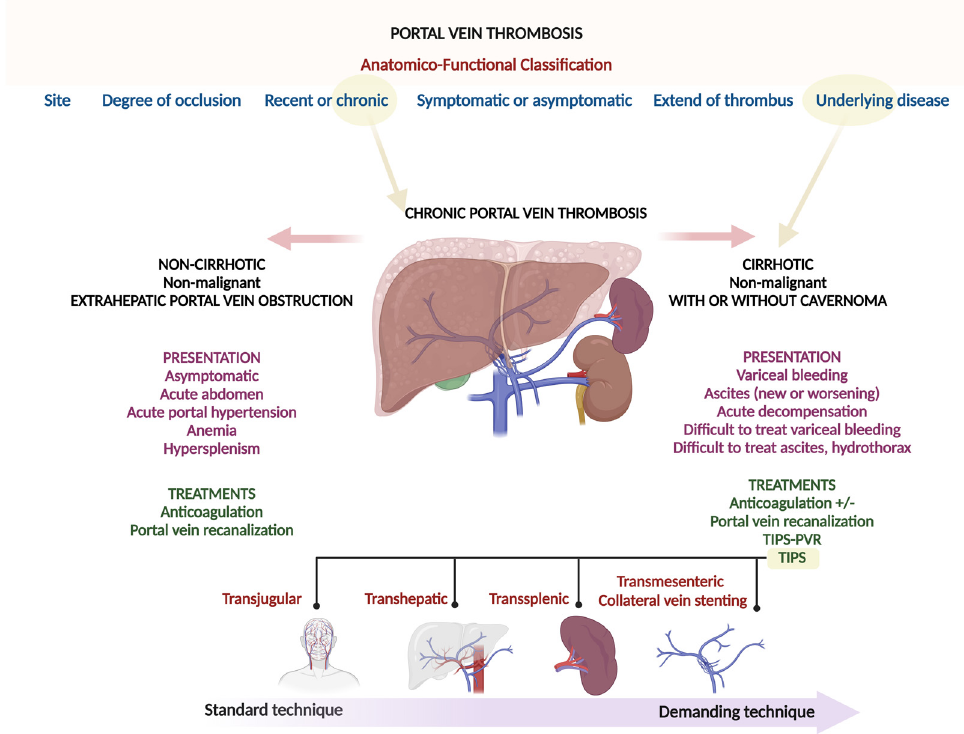
Figure 9. Summary Figure 9. Summary infographics.